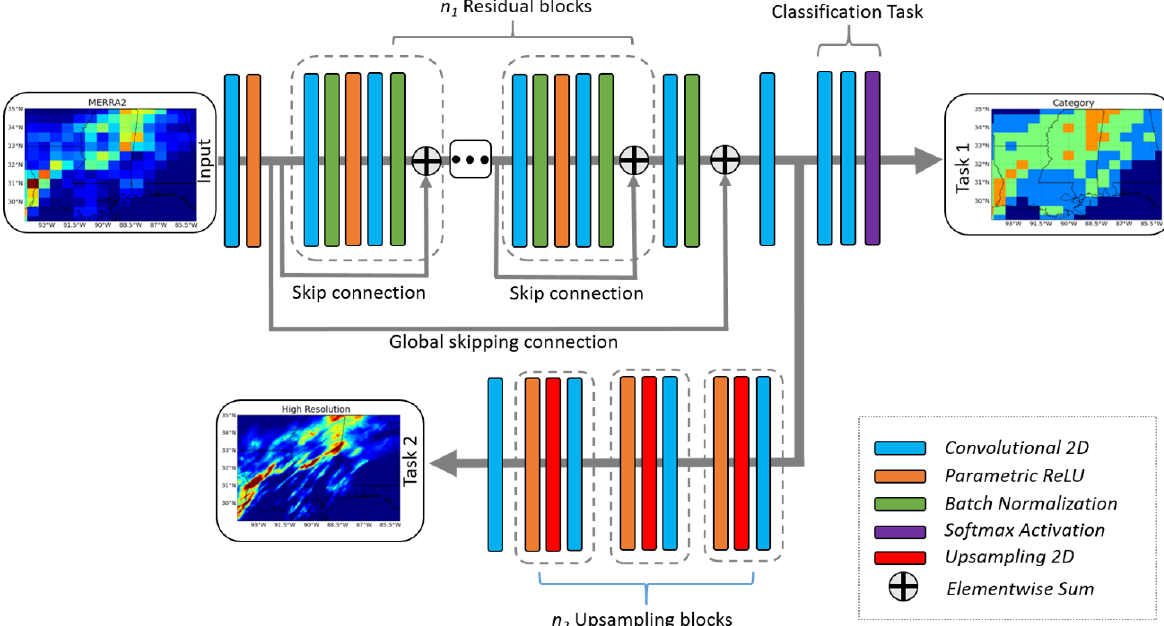
Figure 1. The customized SRDRN architecture with multitask learning, which includes the classification of P categories as an auxiliary task (task 1) in addition to downscaling and bias correcting actual P values (task 2). Note that this figure is modified from the SRDRN architecture shown in Wang et al.